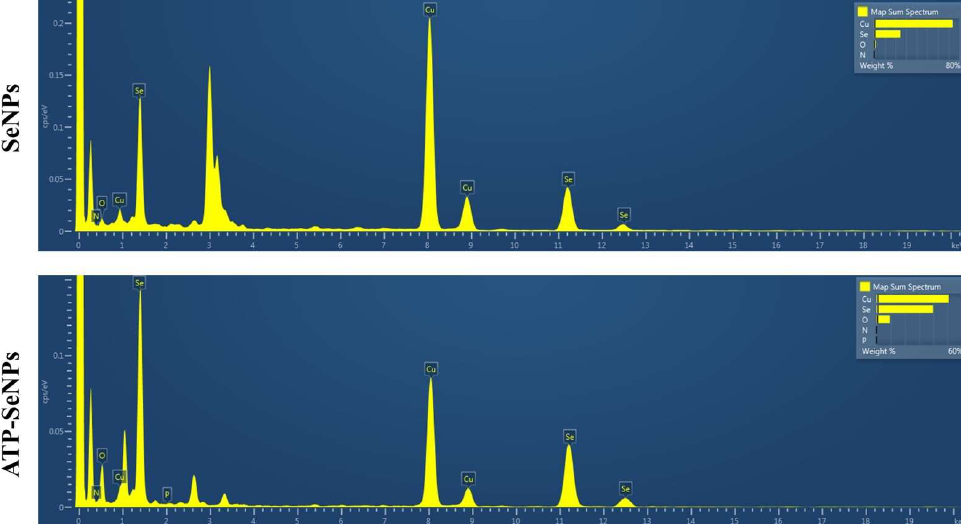
Figure 3. Energy-dispersive X-ray spectroscopy (EDS) analysis of SeNPs and ATP-SeNPs. The ap- pearance of Se and P in the ATP-SeNPs indicates the successful fabrication of ATP-conjugated SeNPs.